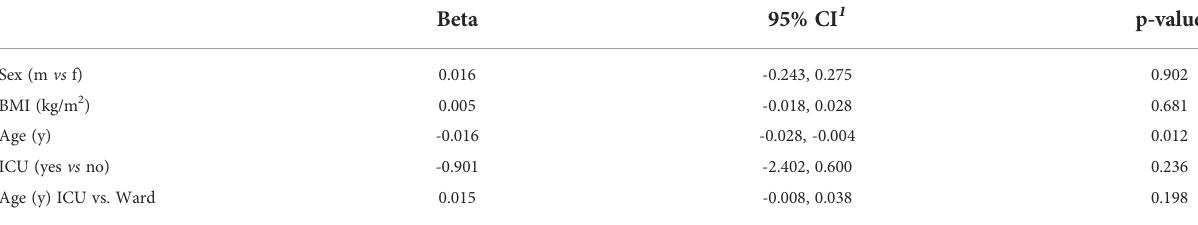
TABLE 2 Multivariate linear regression analysis of FT3 with age, ICU and their interaction-term, adjusted for sex and BMI in hospitalized COVID- 19